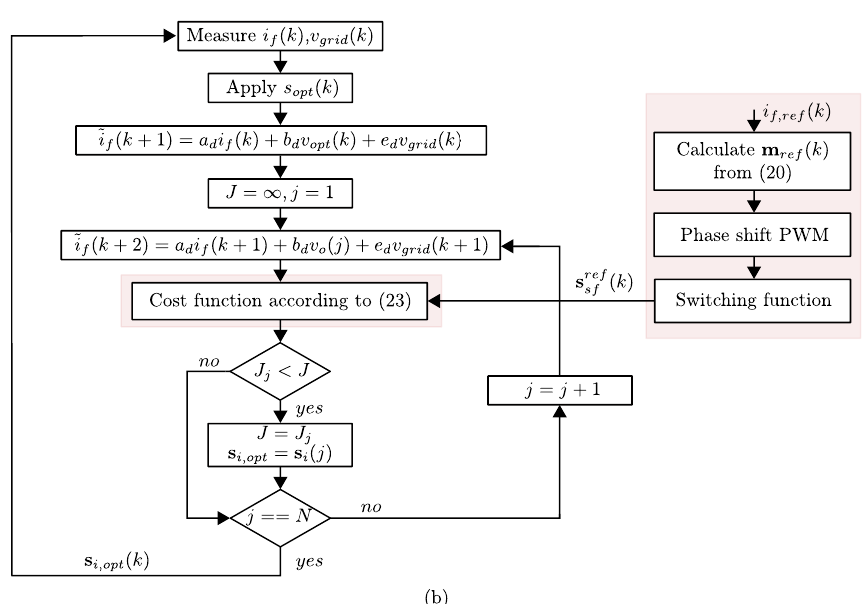
Figure 5. Proposed FCS-MPC applied to grid-connected CHB inverter. ( a ) input restriction generation; ( b ) proposed algorithm flowchart where the red label indicates new or modified stages.